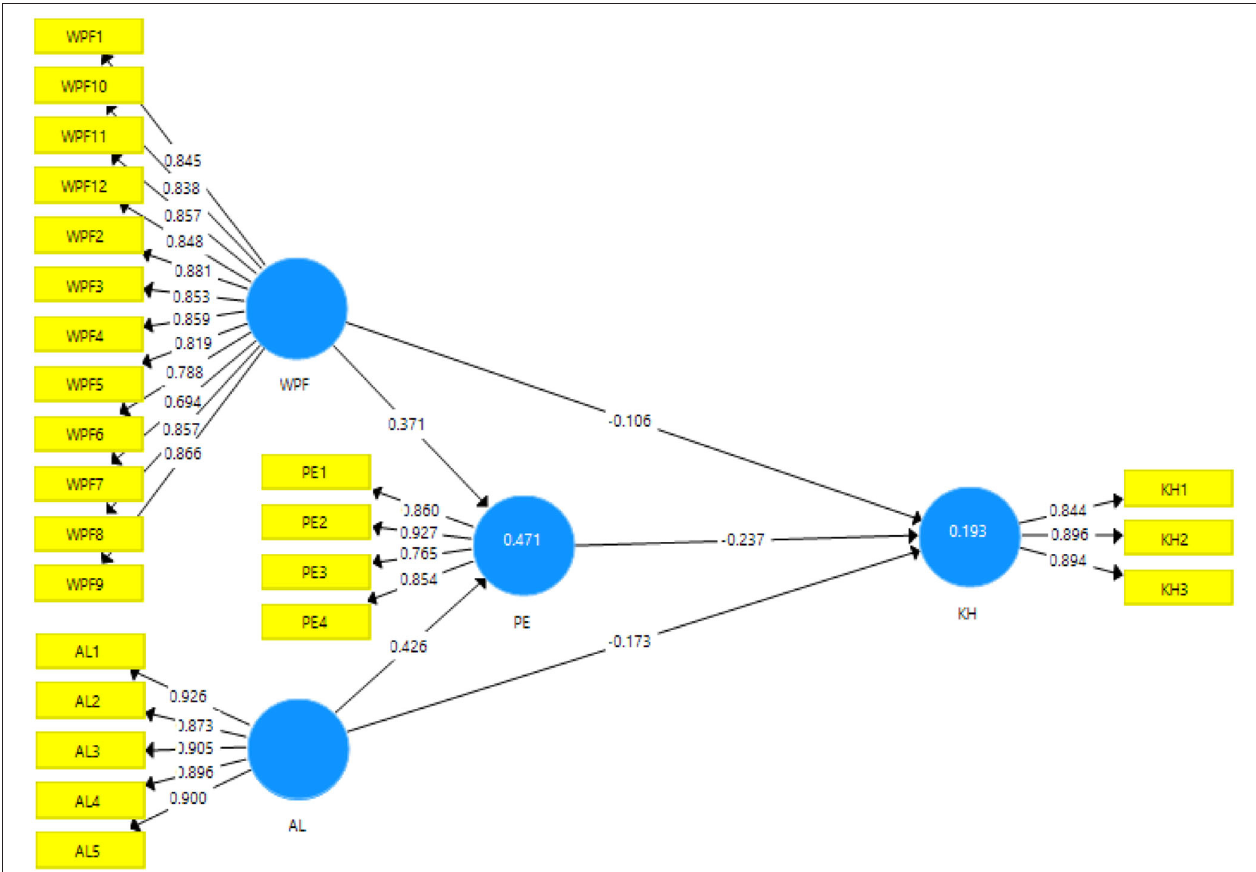
FIGURE 2 | Output of the measurement model. WPF, Workplace friendship; AL, Altruistic leadership; PE, Positive emotions; KH, knowledge hiding.